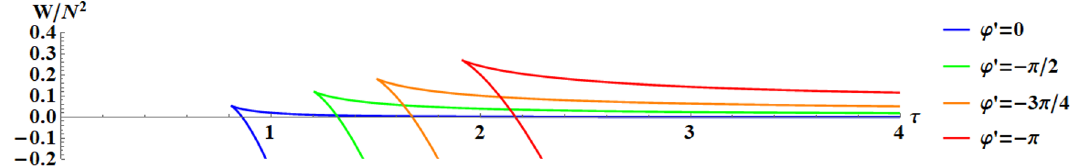
Figure 12 . The BPS free energy W as function of the BPS temperature τ . The two angular momenta are equal ( µ = 0 ) and ϕ 0 = 0 , − π, − 3 π , − 2 π , from left to right. There are two branches 2 in the phase diagram that meet in a cusp. Small black holes (the upper branch) asymptote to a positive BPS free energy W (4.14) at large temperature when ϕ 0 < 0 asym